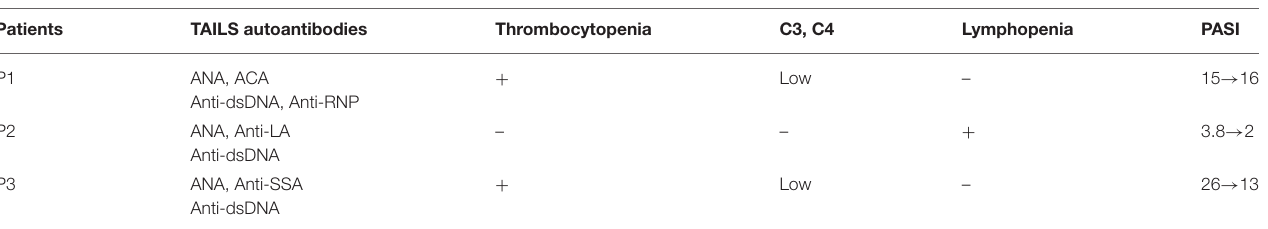
TABLE 2 | Clinical characteristics of patients with TNF- α inhibitor-induced systemic lupus erythematosus. Patients